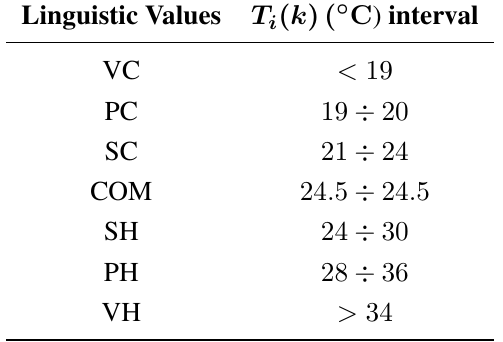
for the summer scenario. i